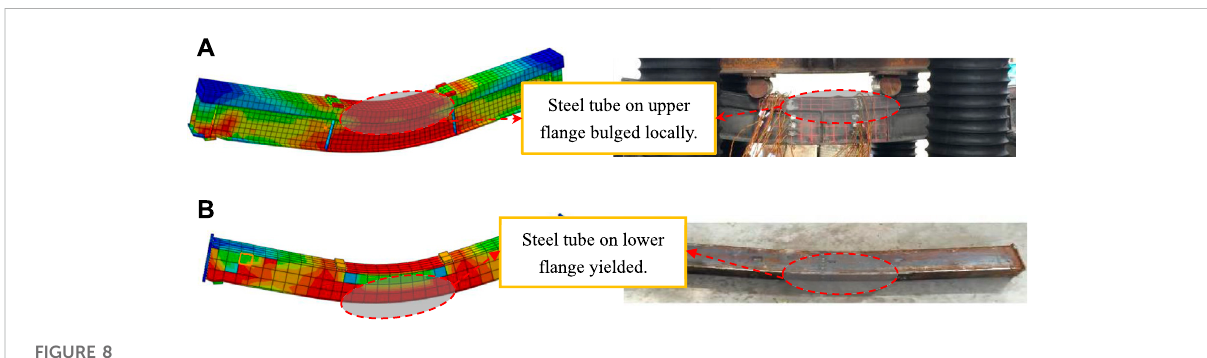
FIGURE 8 Failure modes of L2 and L10 specimens (A) L2 was crushed (B) The steel tube of L10 yielded.